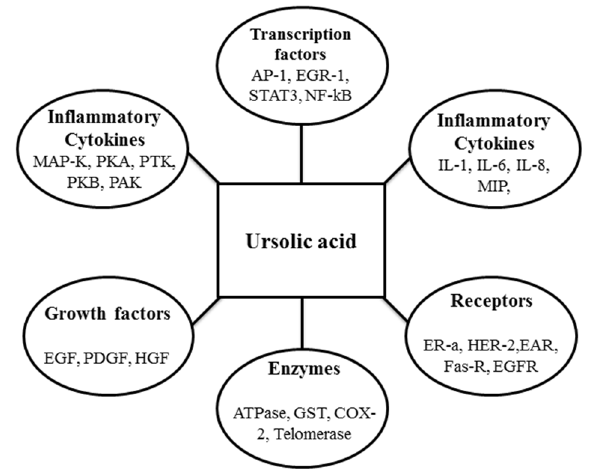
Figure 1. Multiple molecular targets modulated by UA.